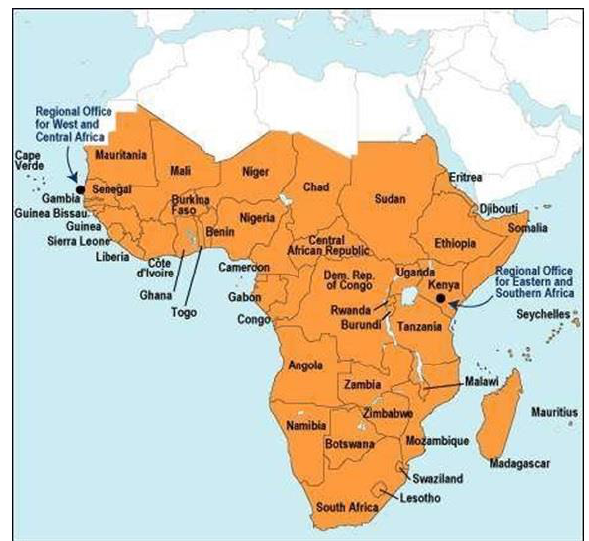
Fig. 2. Sub-Saharan Africa